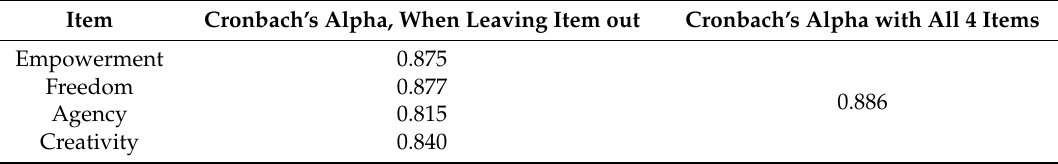
Table 4. Item-scale